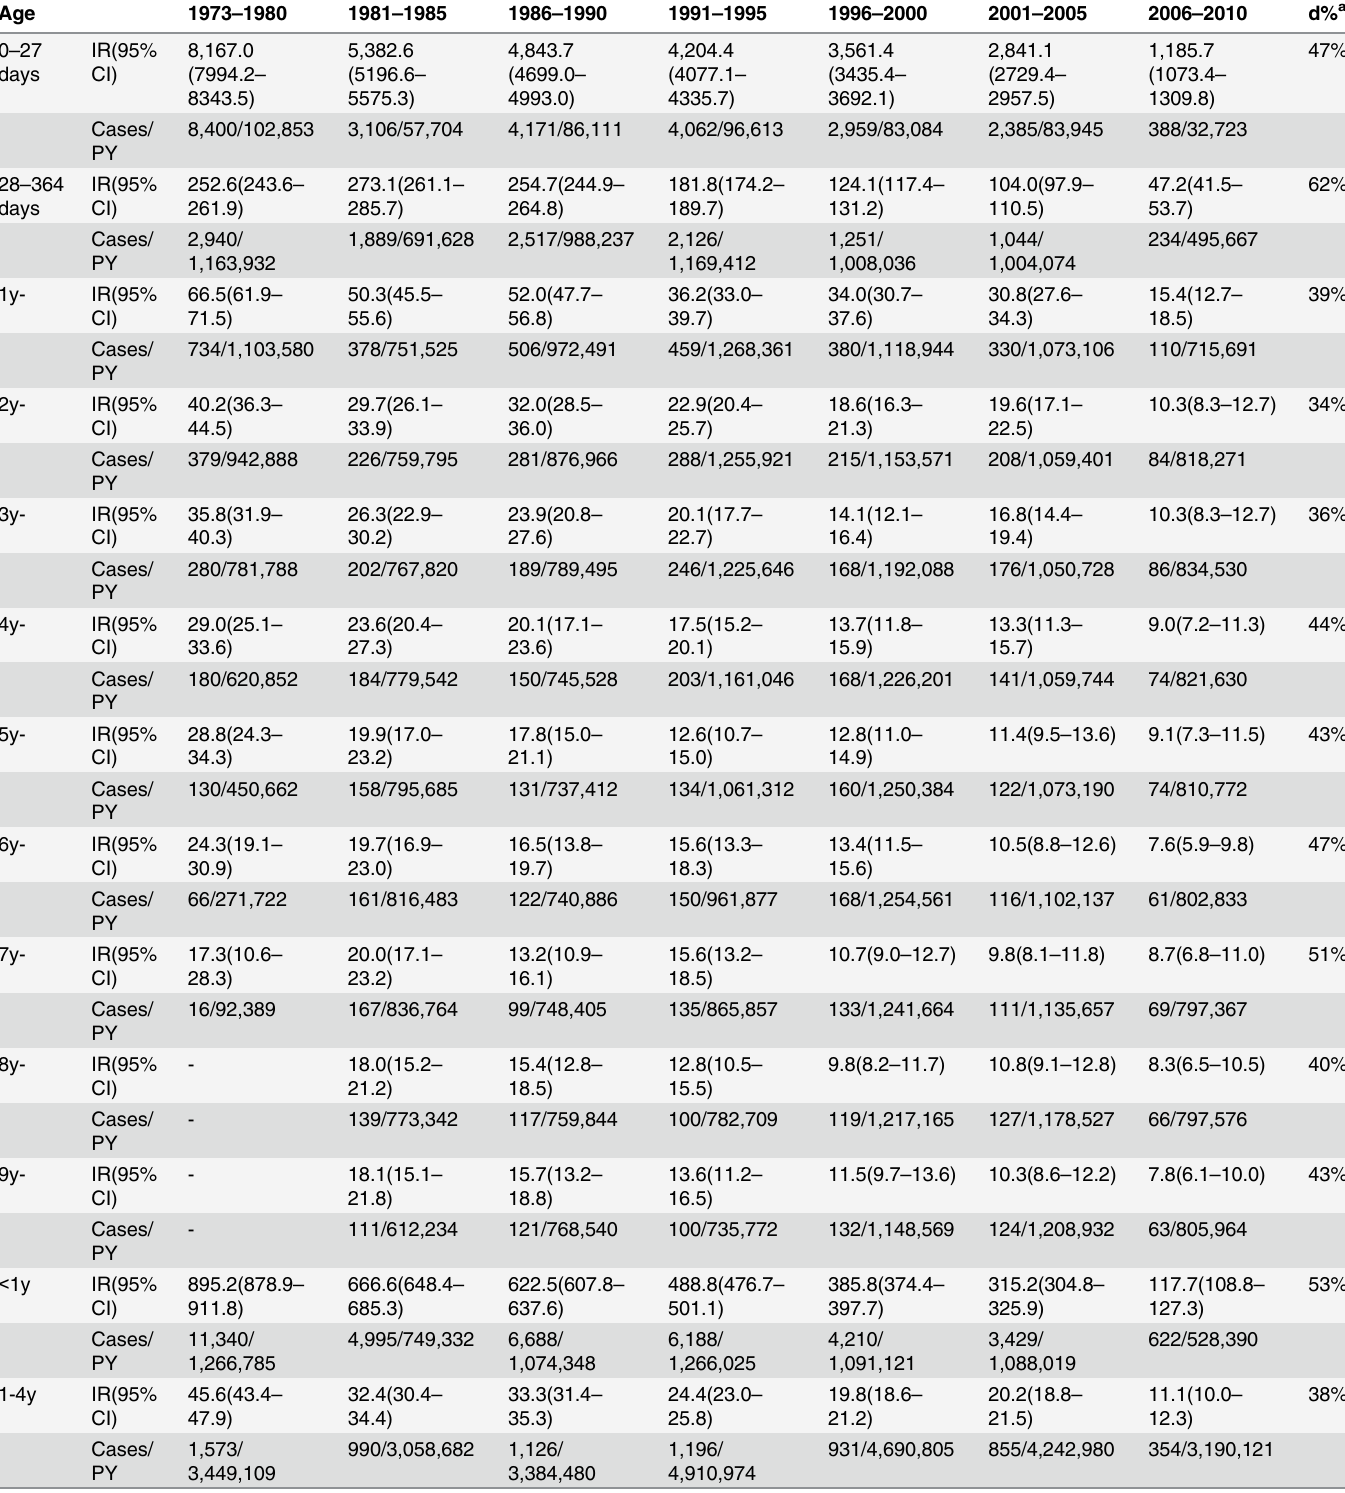
Table 2. Total mortality rates per 100,000 person years by age and calendar